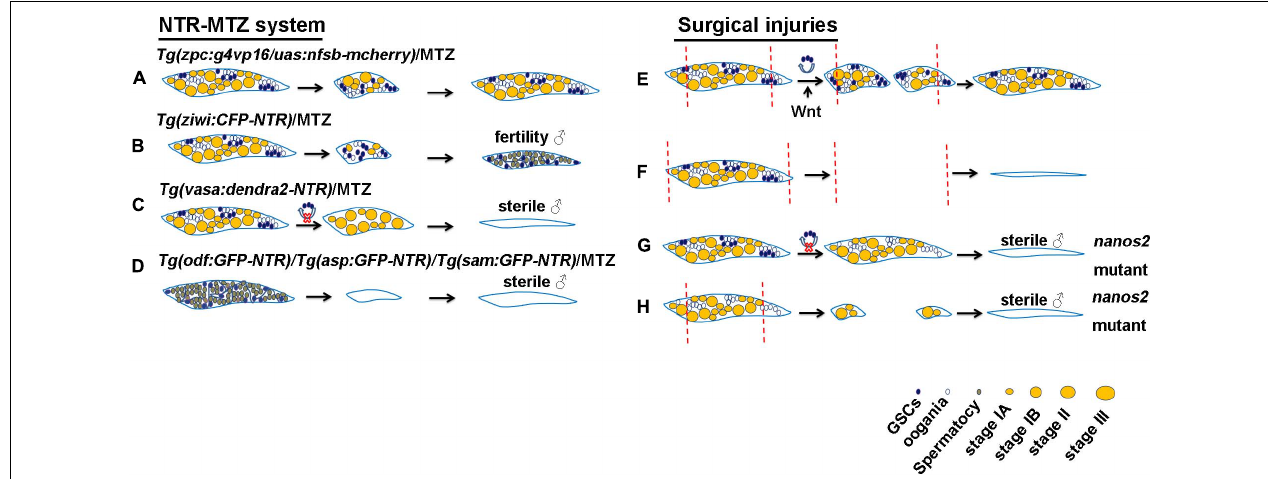
FIGURE 1 | Schematic of genetic ablation by NTR-MTZ system and ovarian surgical injuries in zebrafish. (A) All of GSCs in the Tg(vasa:dendra2-NTR) transgenic background females were ablated by MTZ and they finally reverted into the sterile males. (B) A large number of oocytes in the Tg(zpc:g4vp16/uas:nfsb-mcherry) transgenic background females were ablated by MTZ and were completely regenerated. (C) Most of germ cells in the Tg(ziwi:CFP-NTR) transgenic background females were ablated by MTZ and they finally reverted into the fertile males. (D) Germ cells in the Tg(asp:GPF-NTR) , Tg(sam:GPF-NTR) and Tg(odf:GPF-NTR) transgenic background males were ablated by MTZ and they finally develop into the sterile males. (E) Most of the removed ovarian tissues were regenerated due to the proliferation and differentiation of GSCs and Wnt signaling regulated this process. (F) Regeneration failed to occur after all of ovarian tissues amputation. (G) All of GSCs were lost in nanos2 mutant ovaries and caused sex-reversal. (H) Ovaries in nanos2 mutants failed to regenerate due to loss of GSCs. Red dotted lines represent the distance of ovarian